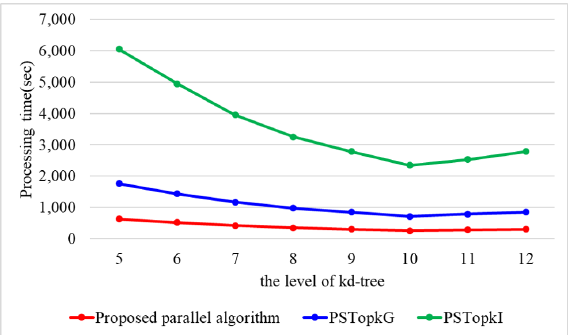
Figure 15. Processing time with a varying level of k d-tree in real